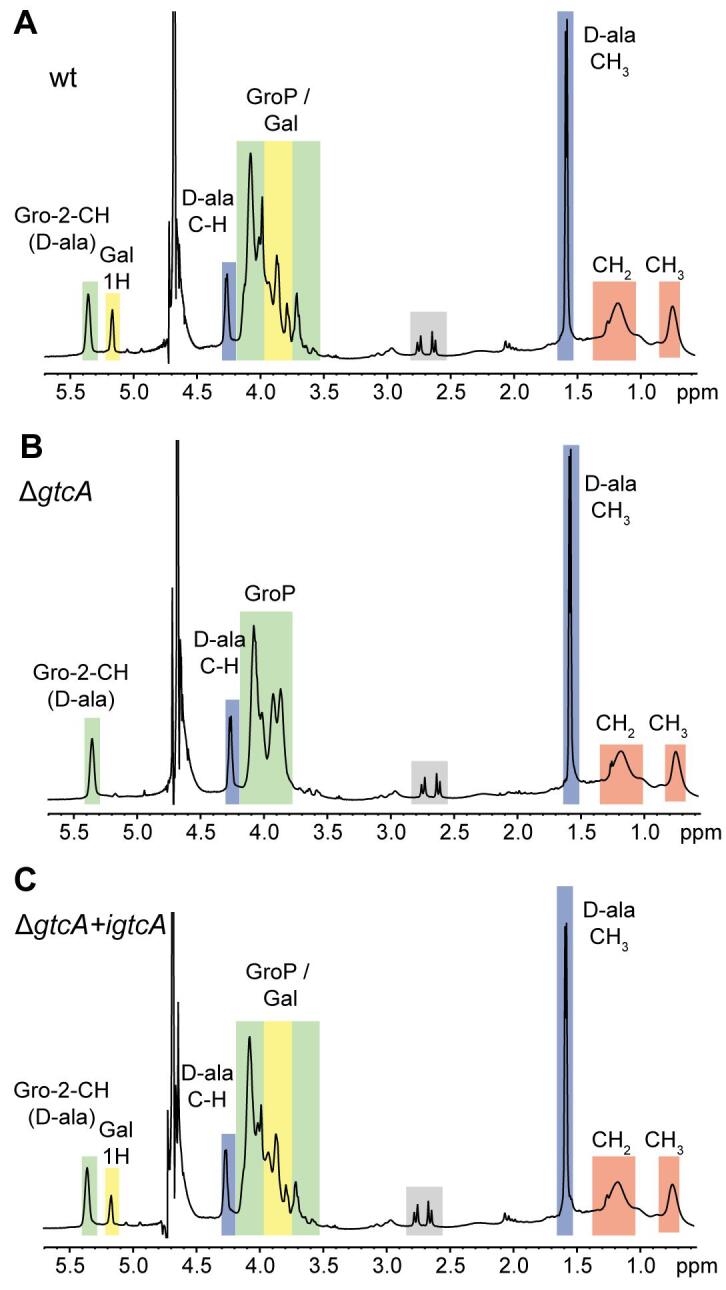
NMR analysis of LTA isolated from wildtype L. monocytogenes strain 10403S, and isogenic gtcA mutant and complementation strains. (A–C) NMR spectra of LTA produced by L. monocytogenes strains (A) 10403S (wt), (B) the gtcA mutant and (C) the gtcA complementation strain (grown in presence of IPTG). Peaks of nonexchangeable protons were assigned to the different LTA components according to previously published spectra and are highlighted in colored boxes (Morath et al., 2001, Morath et al., 2002a, Morath et al., 2002b, Wörmann et al., 2011). The spectra are representatives of two independent experiments.